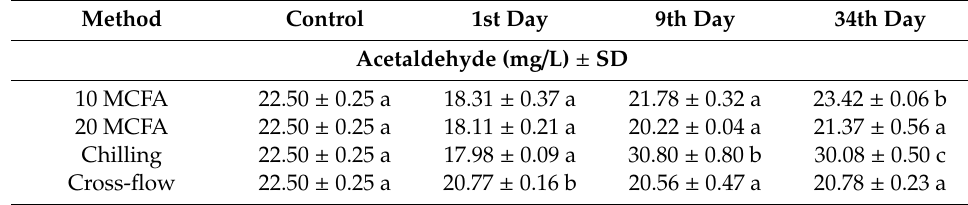
Figure 1. Changes in the acetaldehyde content. Table 2. Changes in acetaldehyde content. The average values ( n = 3) were combined by contribution into homogeneous groups (a, b, c, and d), according to Fisher’s LSD (Least significant difference) test ( α = 0.05).